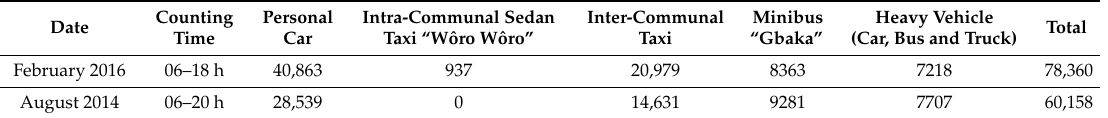
Table 1. Comparison study with Bureau National d’Etudes Techniques et de D é veloppement (BNETD) data collected in August 2014 over a highway in